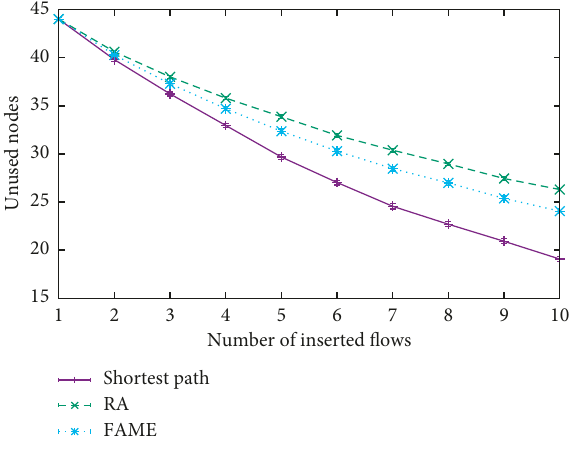
Figure 7: Number of unused